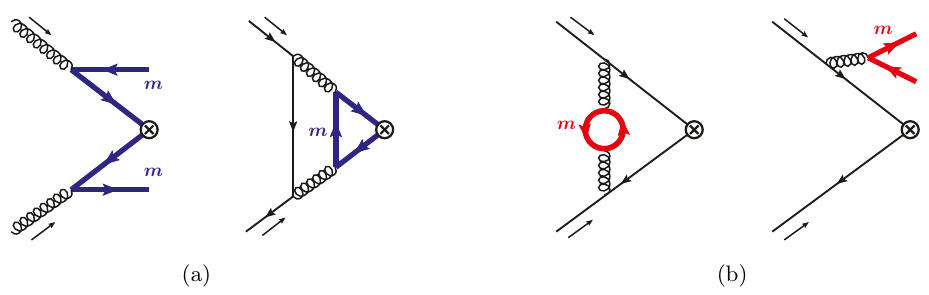
Figure 1 . Primary (a) and secondary (b) heavy-quark mass e(cid:11)ects for Z -boson production. onto the beam axis. The exclusive regime we are interested in corresponds to q T Q , where Q = T (cid:28)